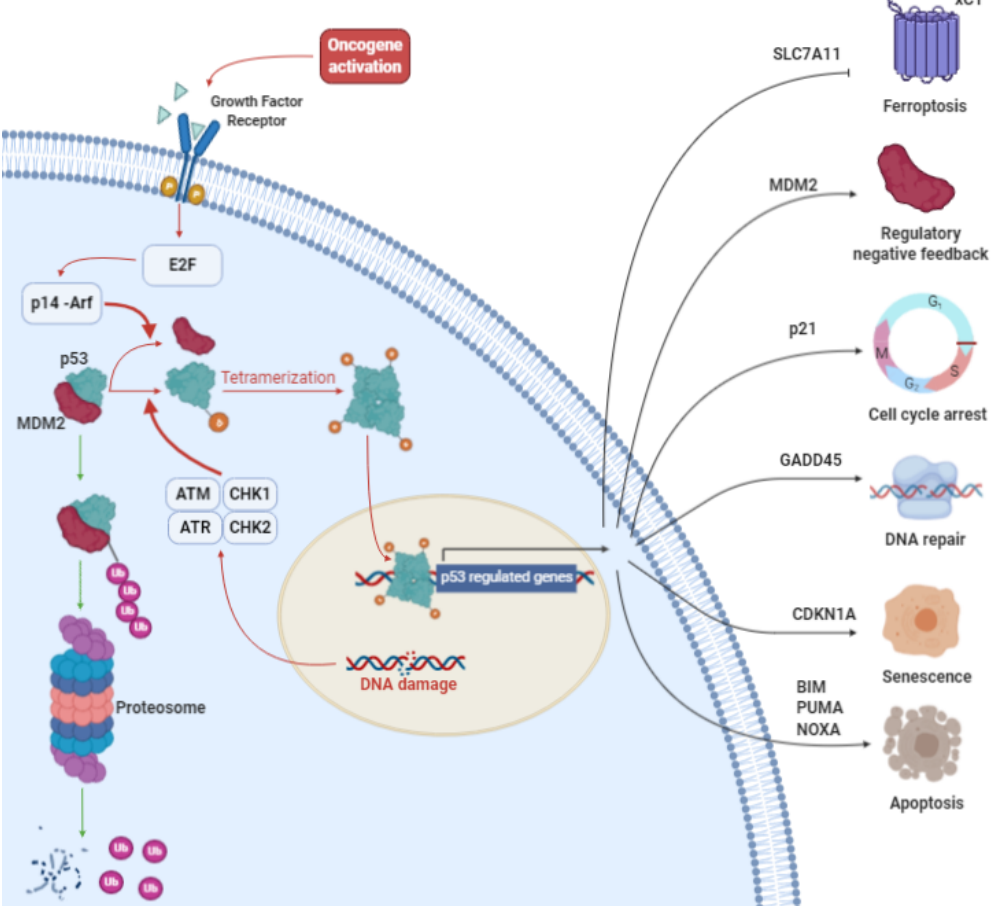
Figure 2. p53 function and transcriptional regulation. Under homeostatic conditions (green arrows), p53 is targeted by MDM2, which induces the proteasome-mediated degradation of p53. After cell injury or stress stimuli (red arrows), p53 levels increase due to several activated pathways that converge on the inhibition of MDM2 or post-translational p53 modifications (e.g., acetylation, phosphorylation). p53 activation strengthens the thermodynamic stability of the protein and induces its homo-tetramerization, inducing the transcription of target genes that are responsible for cell cycle arrest, DNA repair, senescence, apoptosis and ferroptosis. p53 is also a direct transcriptional inducer of MDM2, establishing a negative feedback loop. The role of p53 in inhibiting xCT gene transcription, thus contributing to ferroptosis, is also indicated. This figure was created with BioRender.com.